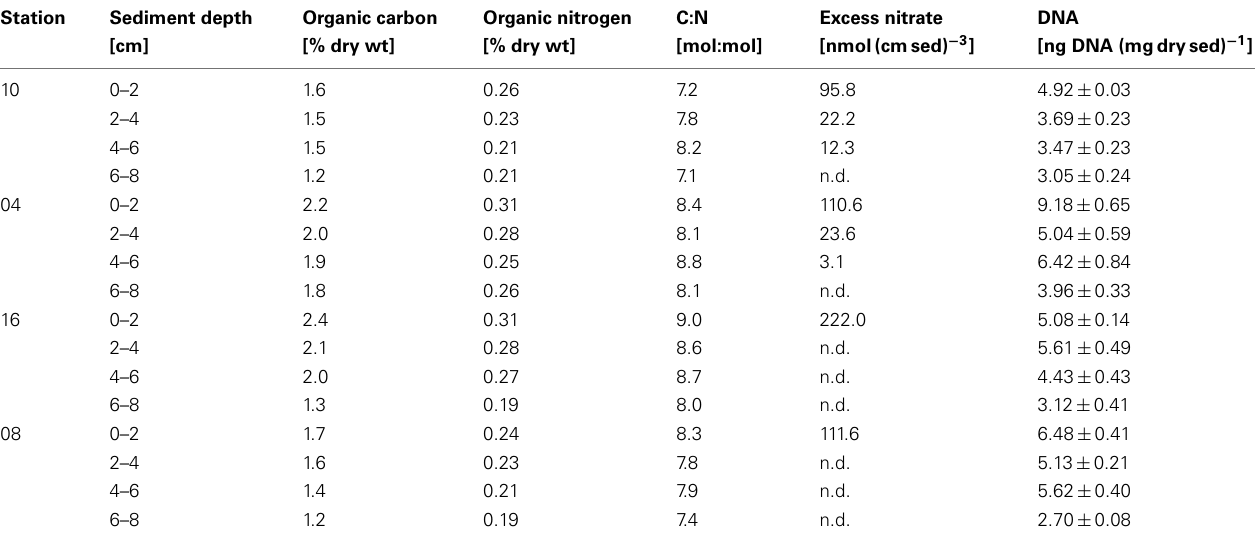
Table 1 | Organic carbon and nitrogen, C:N ratios, N-loss rates, and gene copy numbers of the investigated sediment layers.